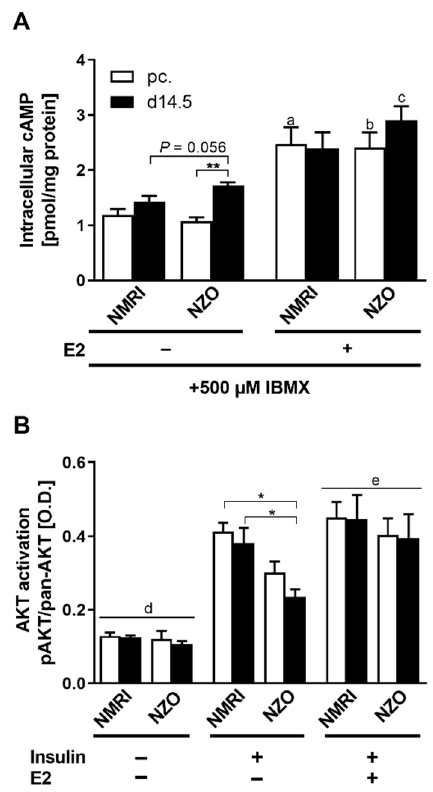
Figure 5. E2 signaling in primary hepatocytes. ( A ) Intracellular cAMP content with E2 stimulation and ( B ) AKT activation (pAKT/pan-AKT ratio) with insulin and E2 stimulation in cultured primary hepatocytes of NMRI and NZO mice at time points preconceptional (white bars) and d14.5 (black bars). Data are presented as means ± SEM (( A ) n = 5, ( B ) n = 4–6 animals per group). * p < 0.05, ** p < 0.01, ( A ) NMRI pc. vs. NMRI pc. + E2: a p < 0.05, NZO pc. vs. NZO pc. + E2: b p < 0.05, NZO d14.5 vs. NZO d14.5 + E2: c p = 0.055, ( B ) multiple comparison tests results between groups: + I vs. w / o I: d p < 0.0001, + I vs. + I + E2: e p < 0.01.